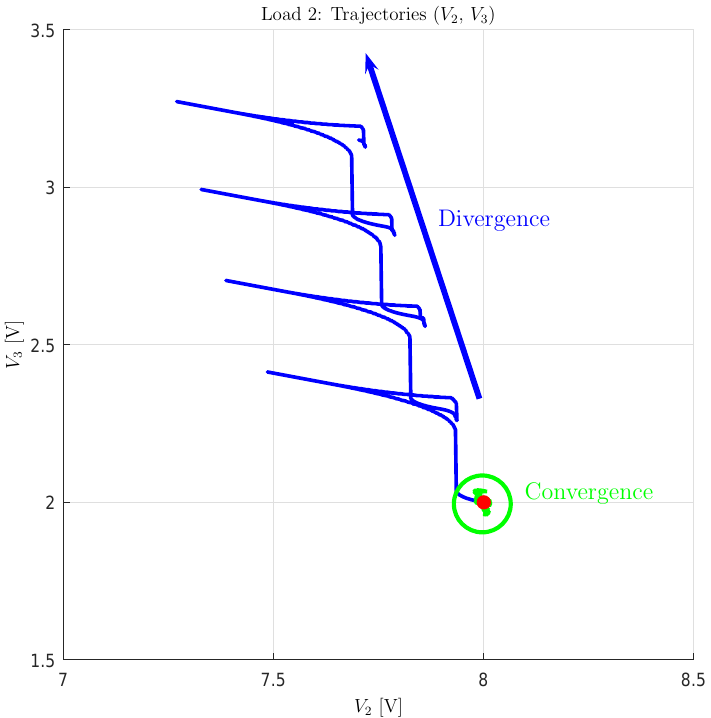
Figure 33. Voltage trajectories for the “Load 2” case using the Minimum Distance Control (blue) and the Variable-Step Control